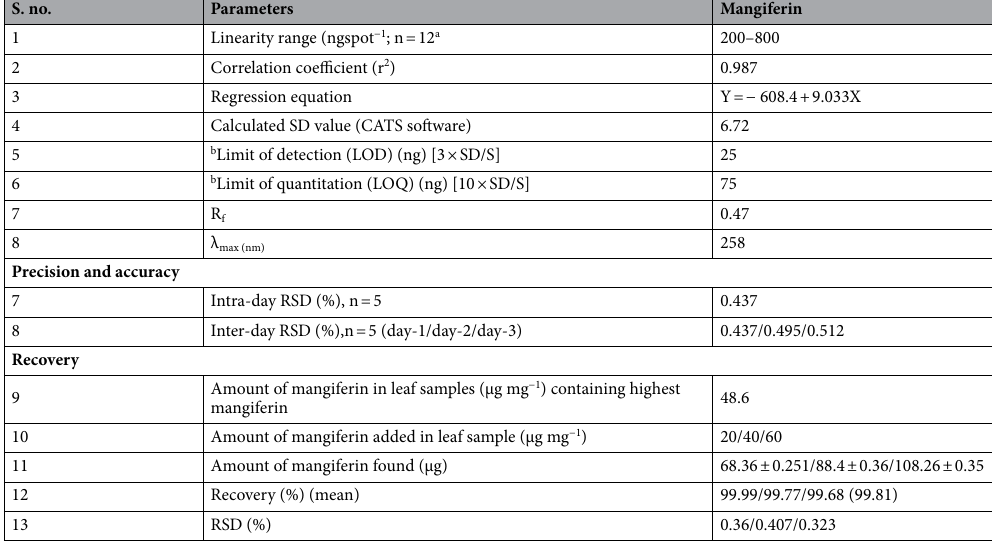
Table 3. Analytical characteristics of the method validation for mangiferin. a Four concentration levels in triplicate; b SD is the standard deviation of the blank response and S is the slope of the calibration plot.